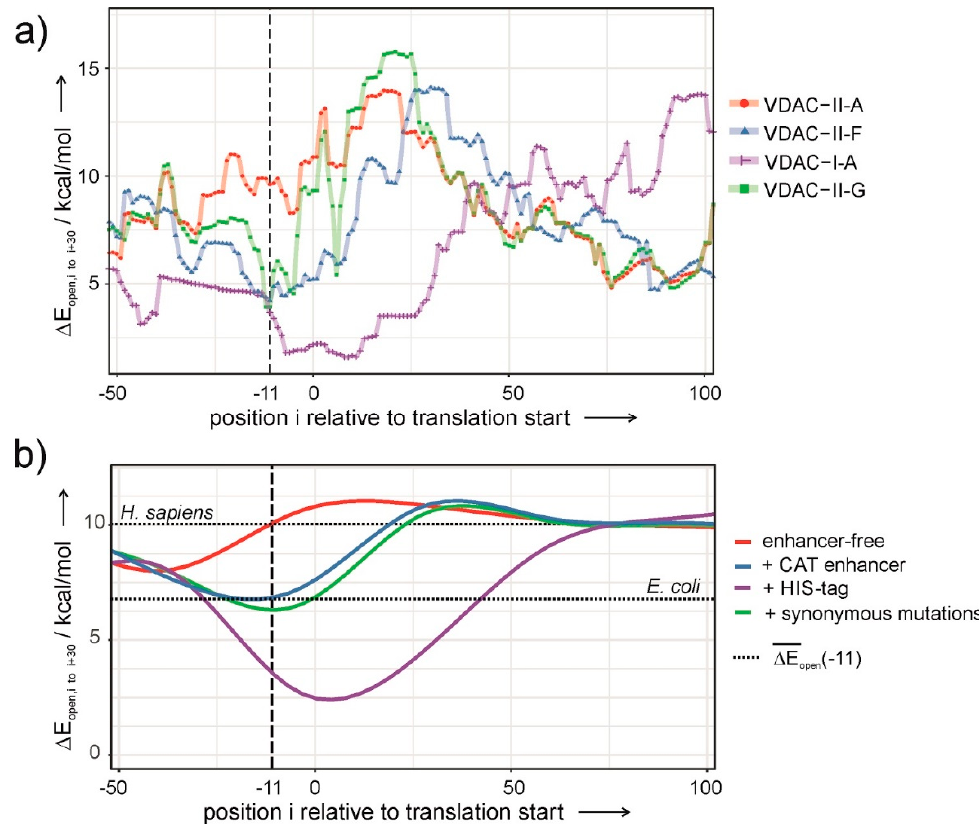
Figure 4. ∆ E open (i) unfolding the 30-nucleotide-long RDS starting at location i with respect to the start codon (i = 0). ( a ) Translatable (VDAC-II-F,G, VDAC-I-A) and not-translatable constructs (VDAC-II-A) for VDAC expression. ( b ) Average ∆ E open (i) for pDEST14 constructs of all human membrane proteins with and without expression enhancers and after coding sequence optimization with synonymous mutations. Dotted lines depict the values of ∆ E open at i = − 11 for the human and E. coli genomes.